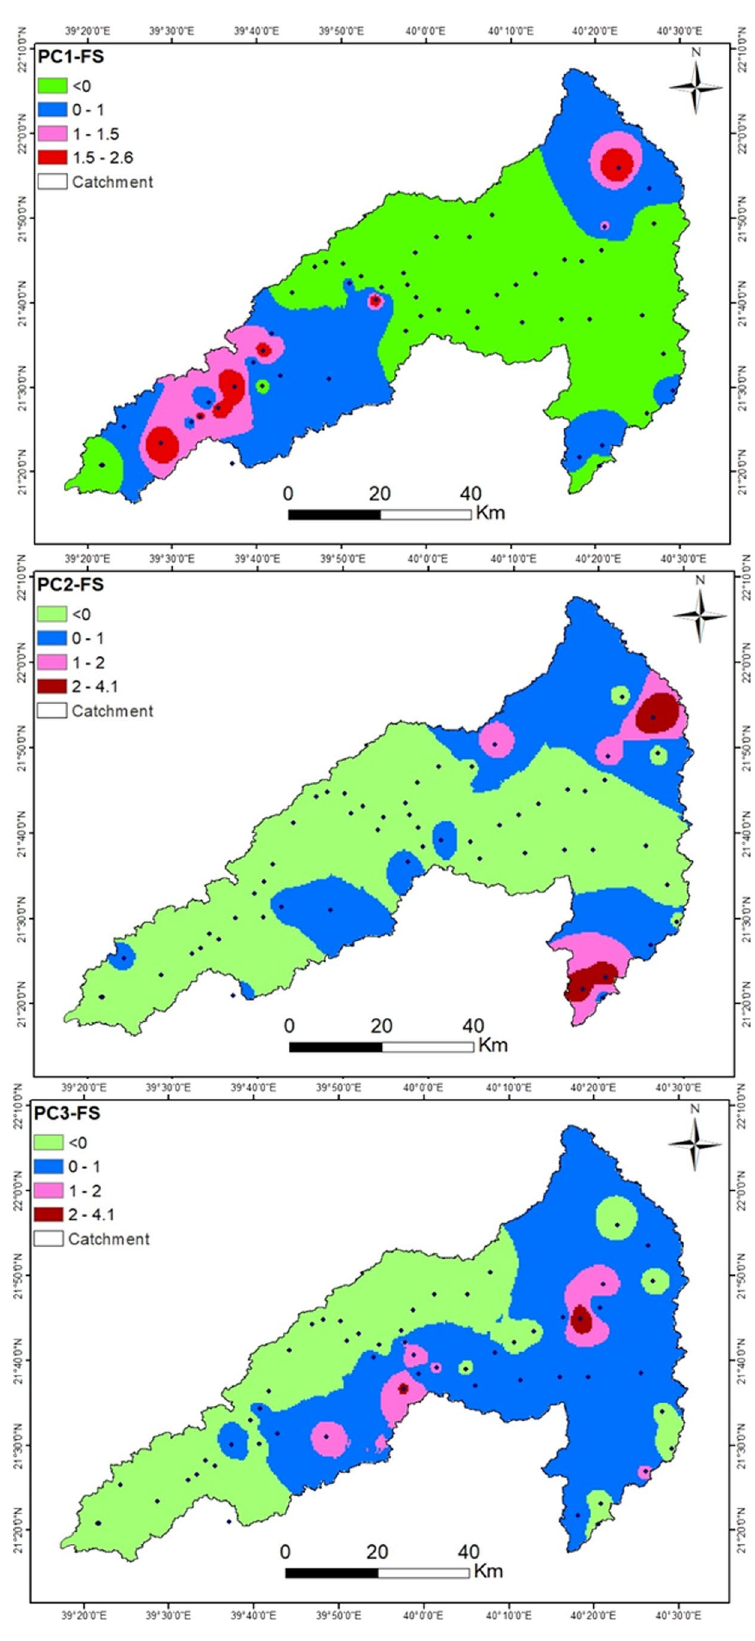
Fig. 4 Spatial variation of prin- cipal components PC1, PC2 and PC3 in the Wadi Fatimah